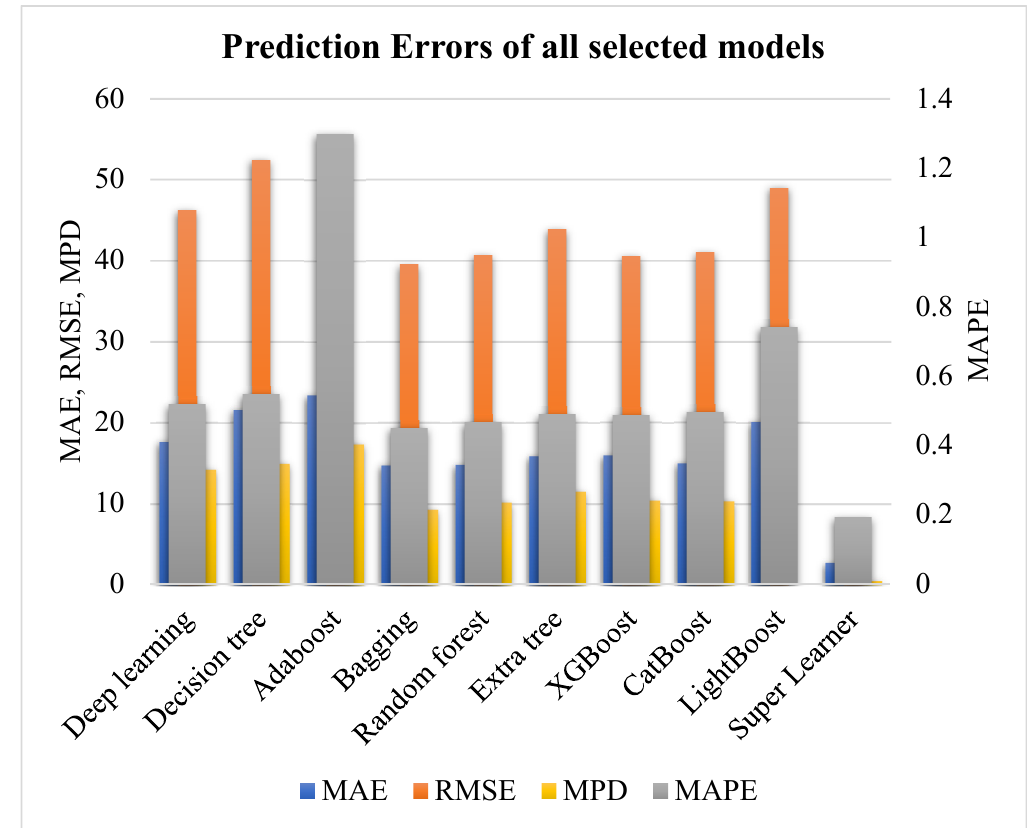
Figure 15. Comparison of prediction errors of all machine learning models based on MAE, RMSE, MAPE and MPD on the test data.